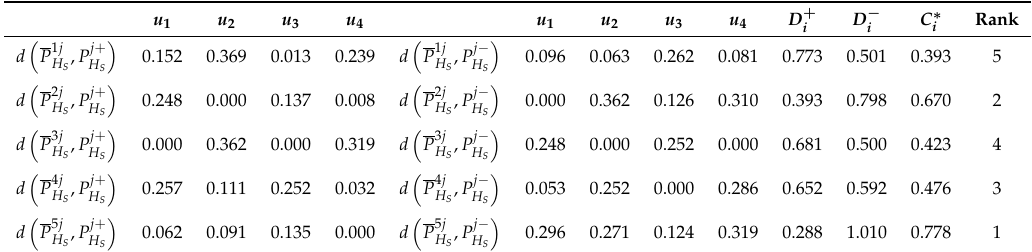
Table 6. The results of distance